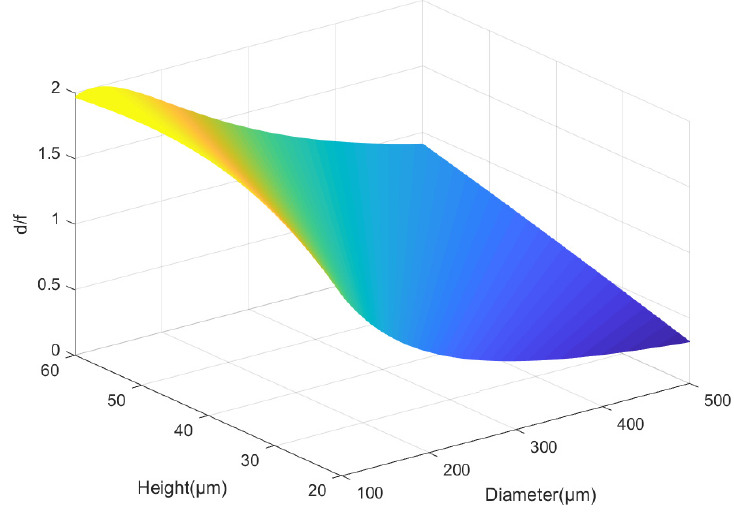
Figure 4. The function image of Equation (5).